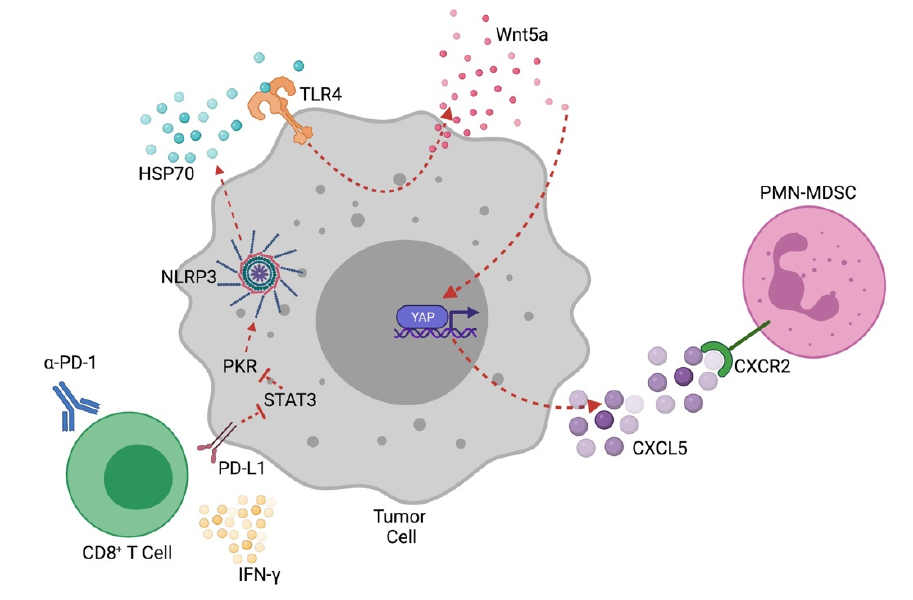
Figure 1. Tumor-Intrinsic NLRP3 Inflammasome Promotes Adaptive Resistance to Anti-PD-1 Im- munotherapy. A PD-L1:STAT3:PKR pathway triggers NLRP3 inflammasome activation in response to anti-PD-1-mediated CD8 + T cell activation [54]. In line with previous work, our studies have shown that PD-L1 cytoplasmic signaling inhibits STAT3 and that this process de-inhibits PKR kinase activity to lead to NLRP3 activation [60,61]. A TLR4-Wnt5a-CXCL5 autocrine pathway promotes PMN-MDSC recruitment in response to tumor NLRP3-dependent release of HSP70. Created with BioRender.com.